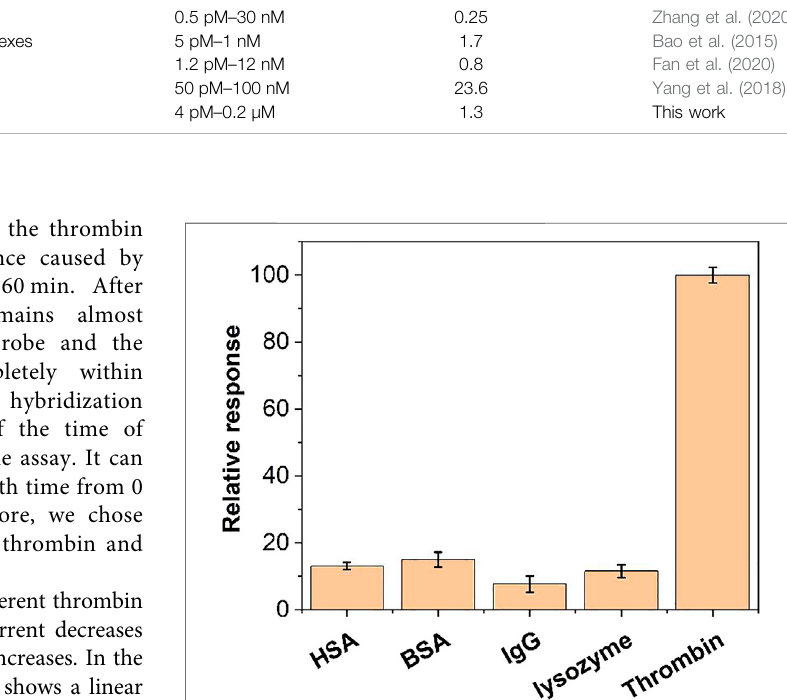
TABLE 1 | Comparison of different methods for thrombin detection. Signal marker